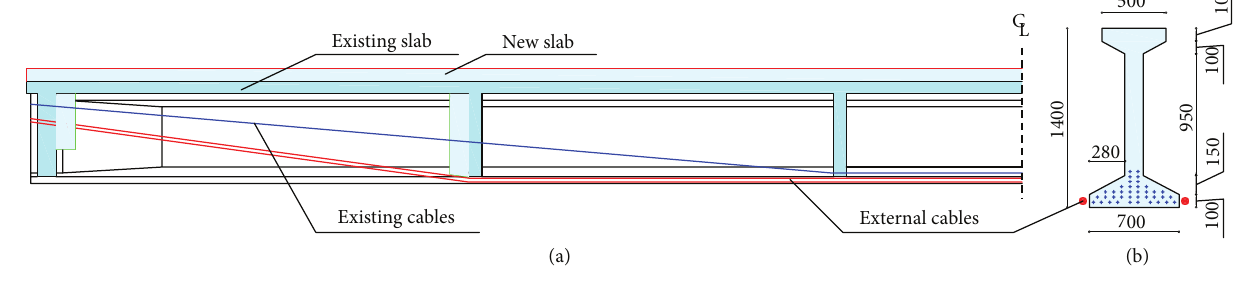
Figure 7: (a) Longitudinal and (b) transversal rehabilitation scheme of beam.